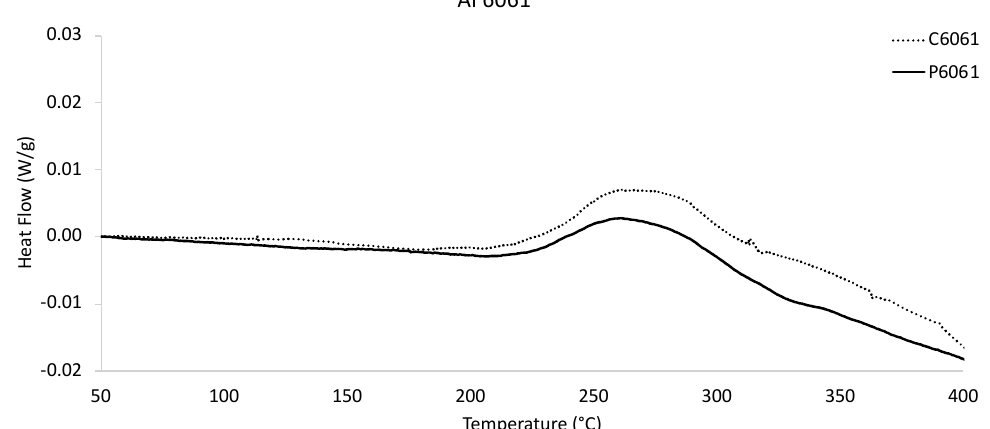
Figure 6. Differential scanning calorimetry-derived heat flow versus temperature curves for the as-cast as well as the as-atomized Al 6061 materials.